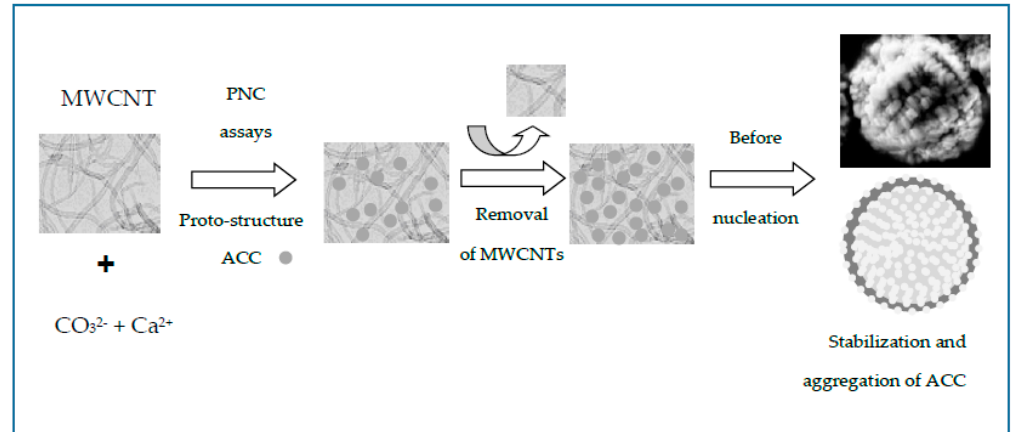
Figure 7. Cartoon of the possible mechanism of the entrapment of MWCNTs into CaCO 3 beads producing stabilized ACC microparticles.